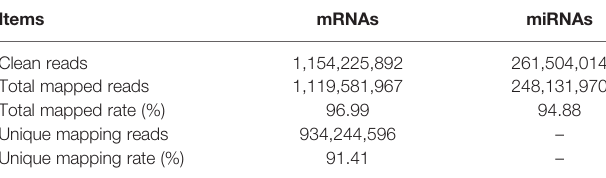
TABLE 1 | Transcriptome sequencing analysis for the identi fi cation of mRNAs and miRNAs in goat